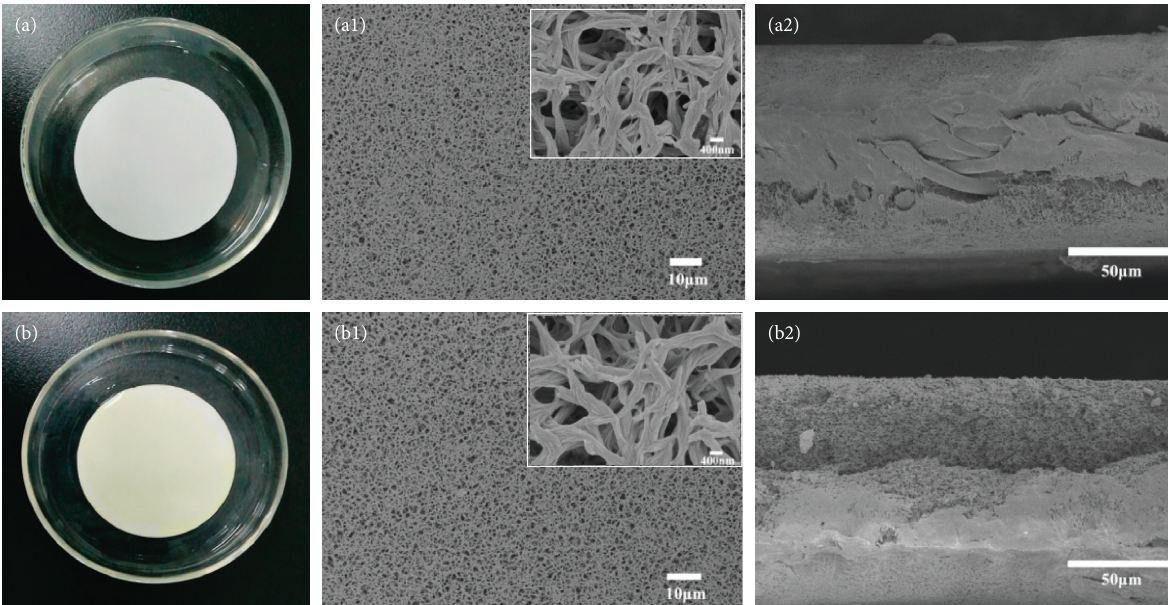
Figure 4: Photographs of the (a) nylon microporous filter and (b) PEI-modified nylon microporous filter. SEM images of (a1, a2) the surface and cross section of the nylon microporous filter and (b1, b2) the surface and cross section of the PEI-modified nylon microporous